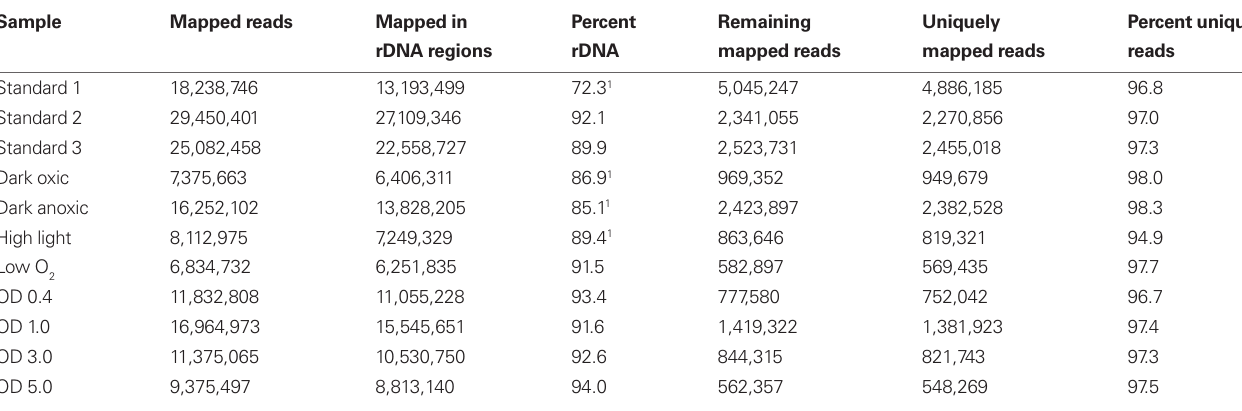
Table 1 | Number of sequences obtained by SOLiD™ sequencing for the samples analyzed in this study.